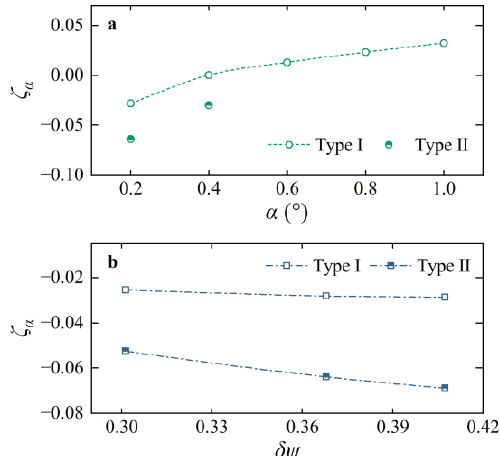
Figure 20. Damping ratio of GV-O under different operating conditions: ( a ) under different GV opening angles with the head coefficient of C ψ = 1.133; ( b ) under different pressure differences be- tween the GV inlet and outlet.